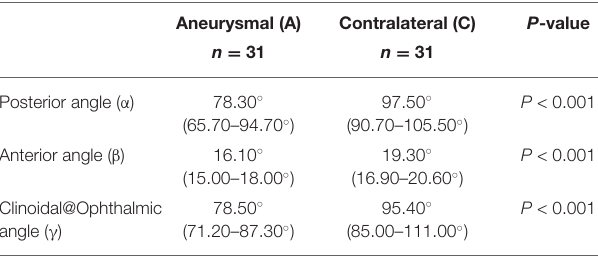
TABLE 3 | Matched pair statistical analysis of aneurysmal and non-aneurysmal contralateral for α , β , and γ angles within same patients. Aneurysmal (A) Contralateral (C)